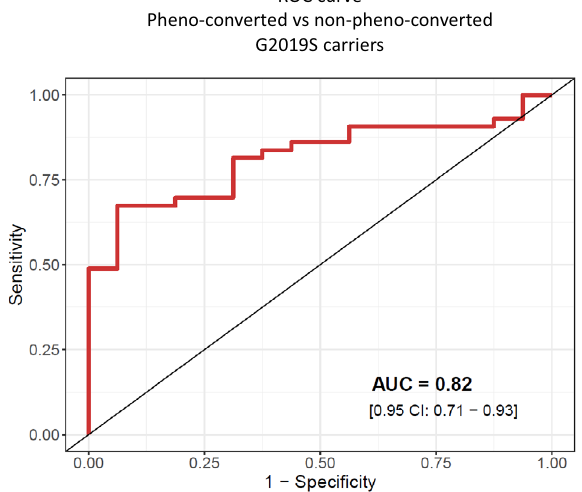
Fig. 5 Area under the curve (AUC) analysis on a receiver operating characteristic (ROC) curve representing the discrimina- tive ability of four miRNAs associated with pheno-conversion (miR-4505, miR-8069, miR-6125, and miR-451a) when comparing DaT-positive L2NMC non-pheno-converted after 8 years of follow- up ( n = 16) vs. all pheno-converted subjects, i.e., L2PD discovery ( n = 20) and validation ( n = 19) sets, and DaT-positive L2NMC diagnosed with PD during the study ( n = 4) (total n = 43). DaT DaT-SPECT imaging, L2NMC LRRK2 non-manifesting carriers, L2PD LRRK2-associated PD